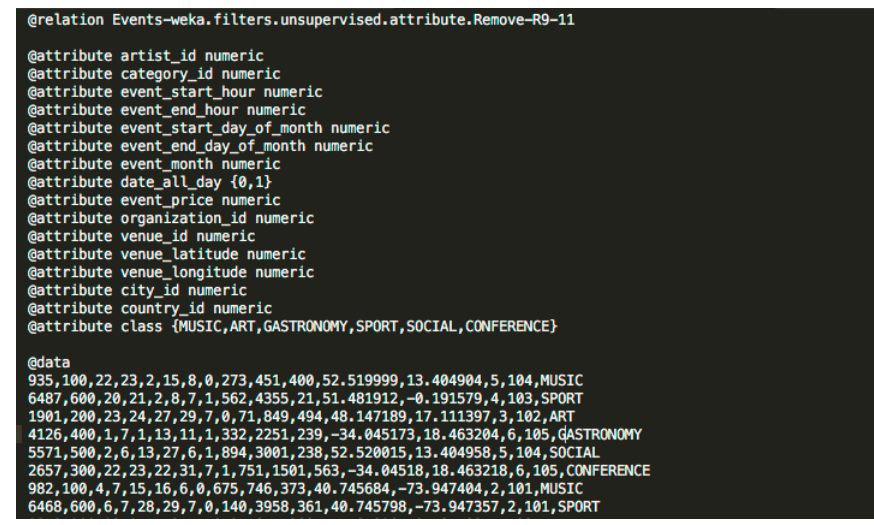
Figure 2. Example of an ARFF File. Table 2. Classes, properties and facets of LODSE ontology.